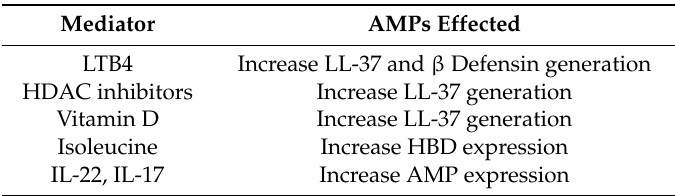
Table 3. Therapeutic Directions: Increase endogenous AMP